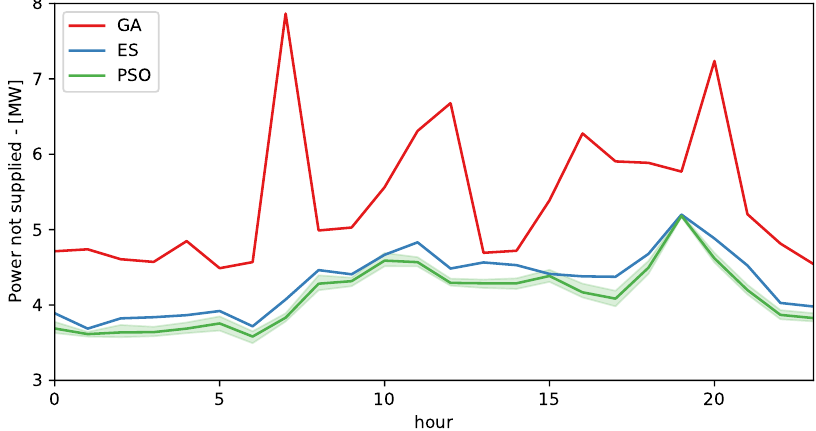
Figure 4. Performance of metaheuristic algorithms for load curtailment